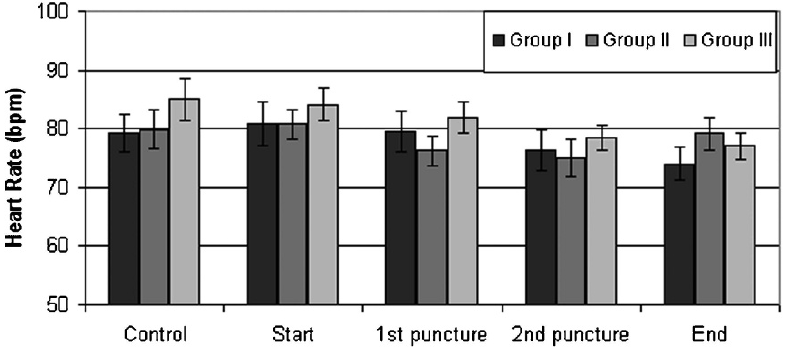
Figure 2 - Heart rate .